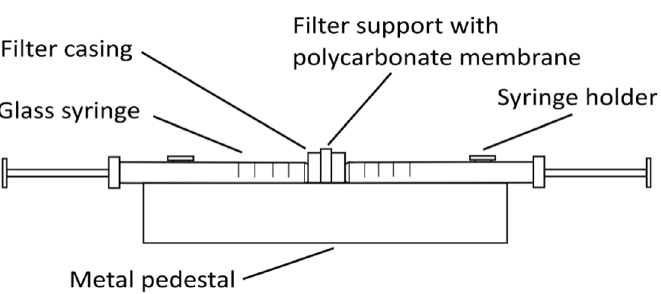
Figure 2. Simple glass syringe hand extruder. The polycarbonate membrane filter of the selected pore size is inserted into the filter support frame. One syringe is then filled with the liposome solution, which is extruded multiple-times from one syringe to the other through the membrane filter, to create small or large unilamellar vesicles.